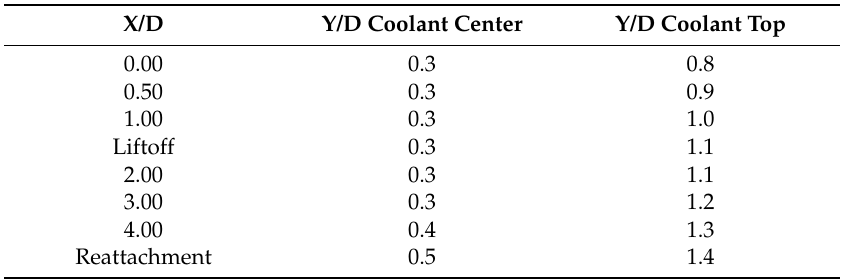
Table 1. Coolant flow trajectories.